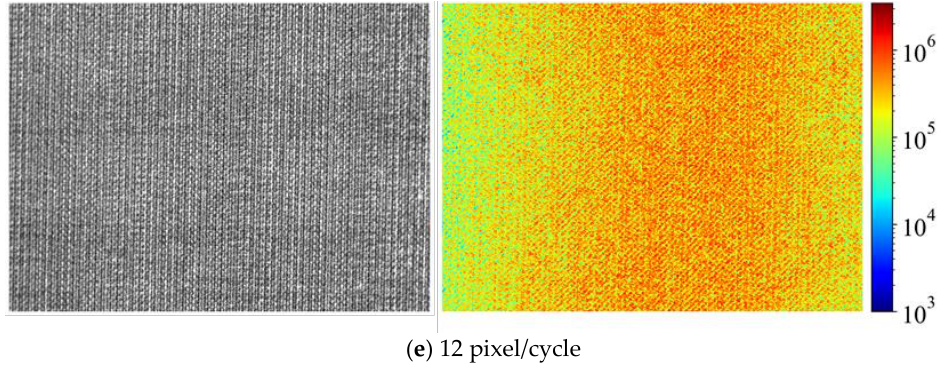
Figure 4. Captured pictures ( left ) and their focus measure maps ( right ) for each pixel-cycle length.